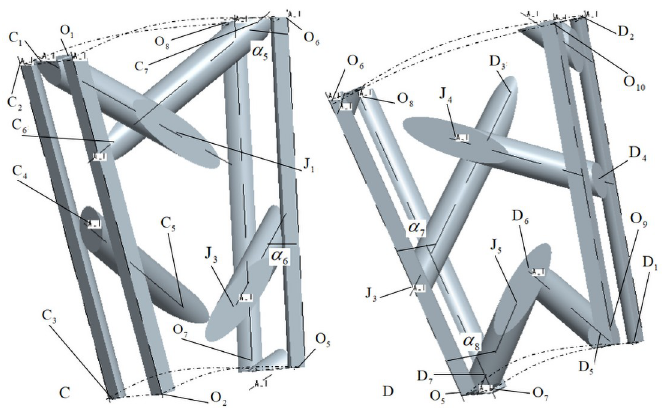
Fig 7. Position relation diagram of internal unit cells C and